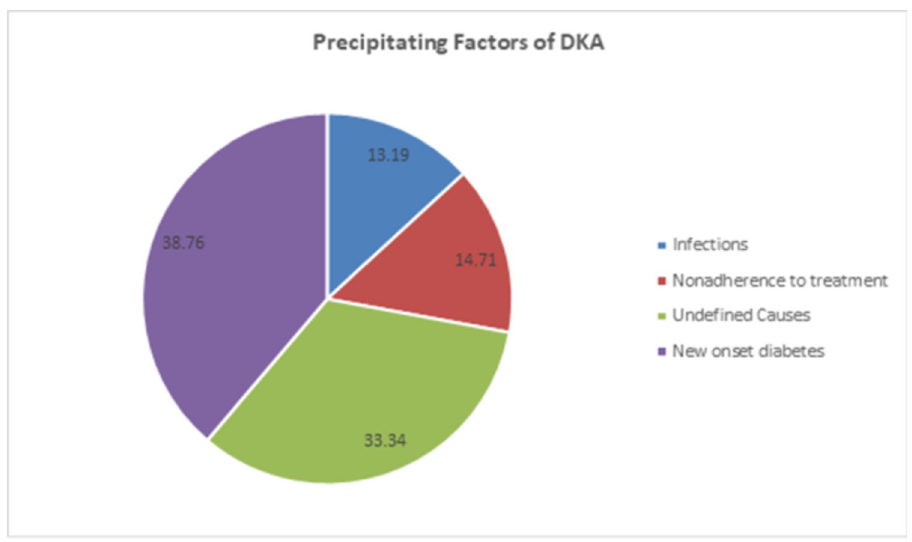
Fig 1. Precipitating factors of DKA patients admitted at DTGH from August 2010 to May 31, 2018(n = 387).